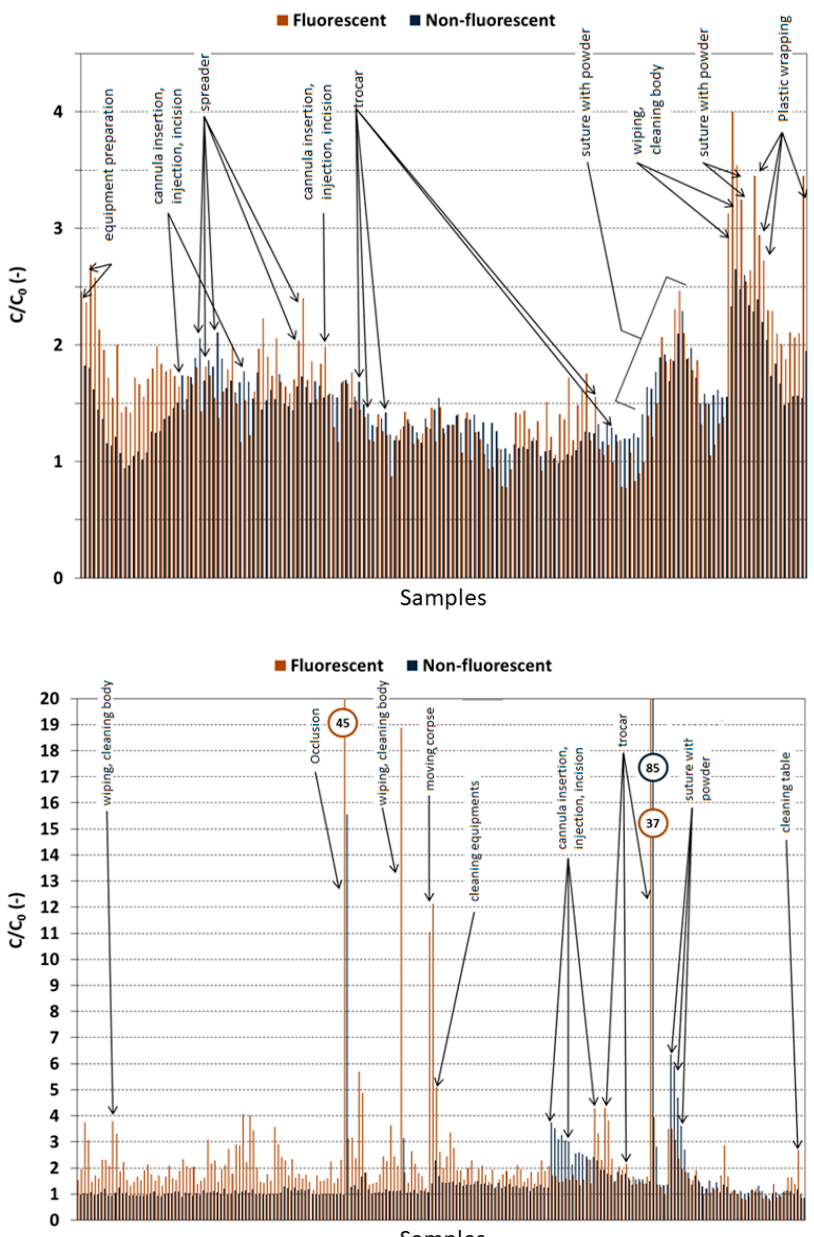
Figure 3. Chronology of emission factors (C/C 0 ) for fluorescent (biological) and non-fluorescent (non-biological) particles for successive samples of one minute in lab A ( top ), B ( middle ), and C ( bottom ). (C: Concentration and C 0 : baseline concentration). The numbers in the circles represent the C/C 0 ratio that were off-scale and were obtained for extreme generating events (orange for fluorescent particles and blue for non-fluorescent particles).